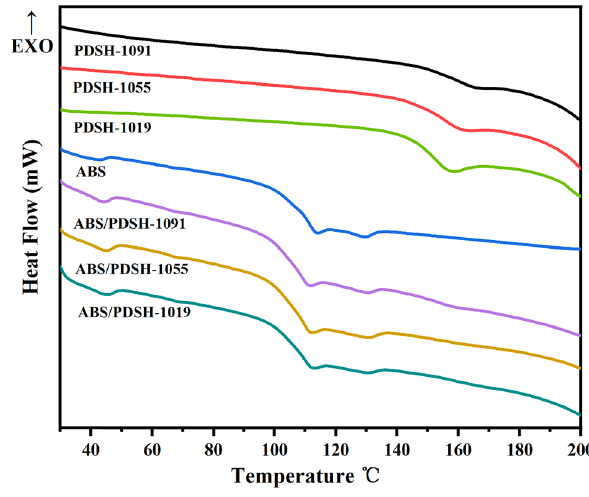
Figure 5: DSC thermograms of PDSH, ABS, and ABS/PDSH composites.